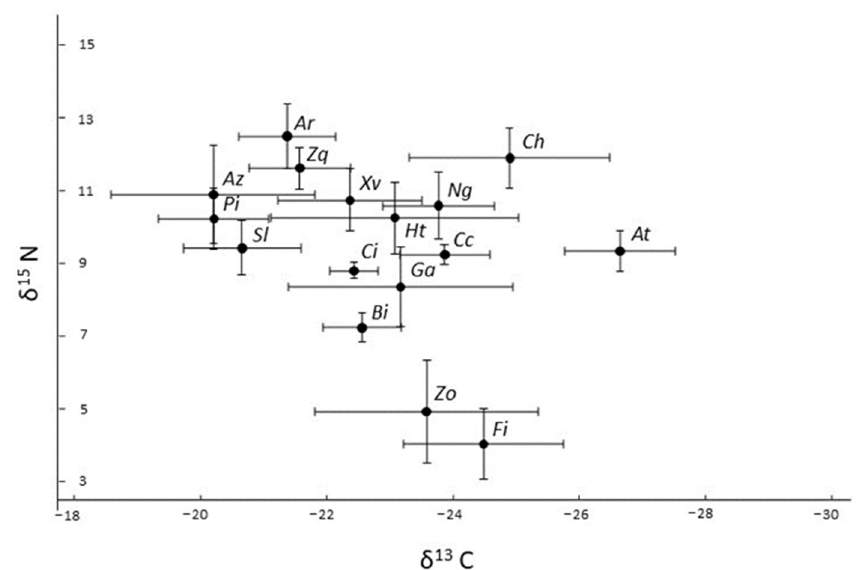
Figure 4. Lake Zacapu food web plot based on analysis of δ 13 C and δ 15 N stable isotope values, mean δ 13 C and δ 15 N (±1SE). Acronyms: Ar = Alloophorus robustus , Az = Allotoca zacapuensis , Ht = Hubbsina turneri , Sl = Skiffia lermae , Xv = Xenotoca variata , Zq = Zoogoneticus quitzeoensis , Ch = Chirostoma humboldtianum , Pi = Poeciliopsis infans , Ci = Ctenopharingodon idella , Cc = Cyprinus carpio , Ng = Notropis grandis , At = Algansea tincella , Ga = Goodea atripinnis , Bi= benthic invertebrates, Zo = zooplankton, Fi =phytoplankton.